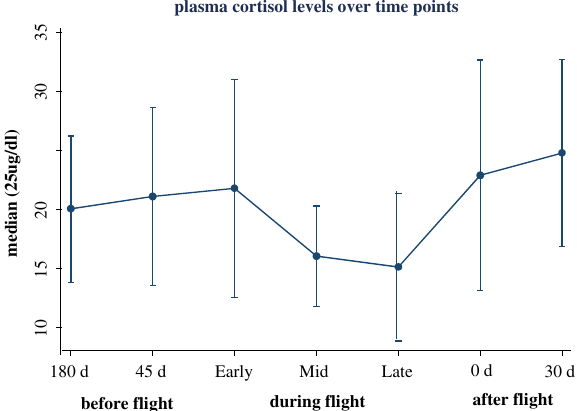
Fig. 4 Estimated medians and 95% con fi dence limits for plasma